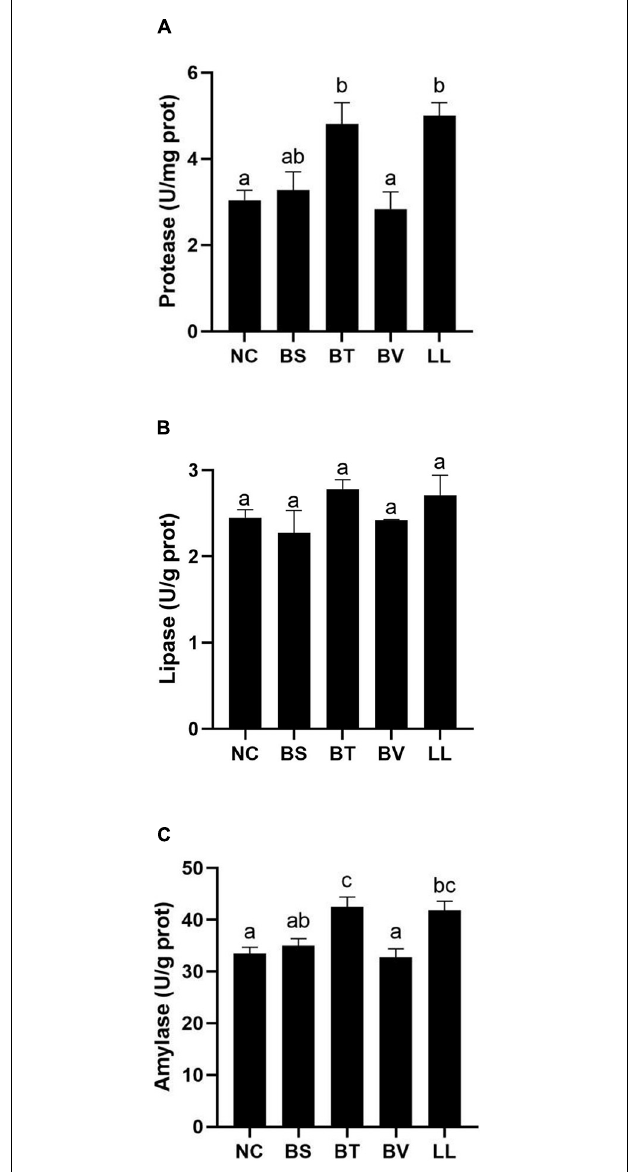
FIGURE 2 | Digestive enzymes activity in jejunum of bullfrog: (A) protease, (B) lipase, and (C) amylase. Bars with different letters were significantly different ( p < 0.05). NC, control diet; BS, control diet containing 1 × 10 7 CFU/g of Bacillus siamensis ; BT, control diet containing 1 × 10 7 CFU/g of Bacillus tequilensis ; BV, control diet containing 1 × 10 7 CFU/g of Bacillus velezensis ; and LL, control diet containing 1 × 10 7 CFU/g of Lactococcus lactis